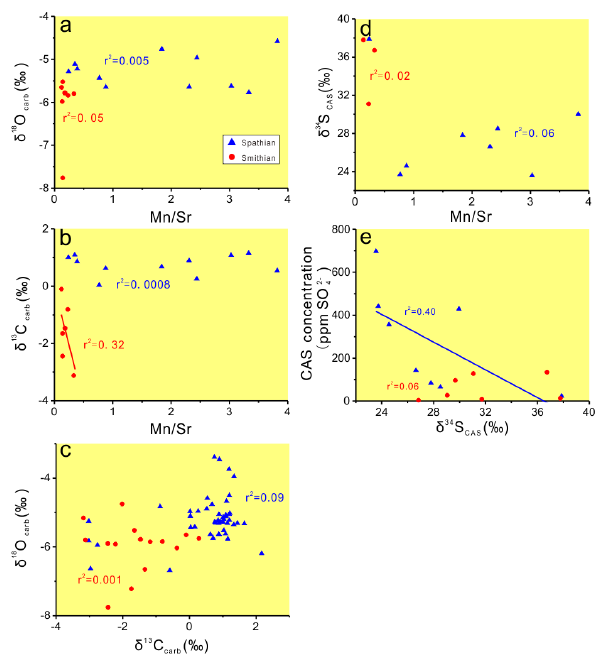
Figure B1. Elemental and stable isotope crossplots: (a) δ 18 O carb vs. Mn/Sr ratio; (b) δ 13 C carb vs. Mn/Sr ratio; (c) δ 18 O carb vs. δ 13 C carb ; (d) δ 34 S CAS vs. Mn/Sr ratio; (e) CAS concentrations vs. δ 34 S CAS . CAS (carbonate-associated sulfate) concentration is given as ppmSO 2 − 4